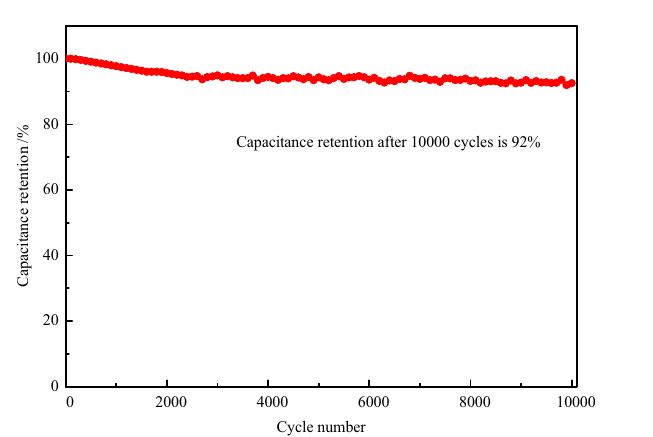
Figure 11. Cyclic performance of AC 12 at current density 5 A g −1